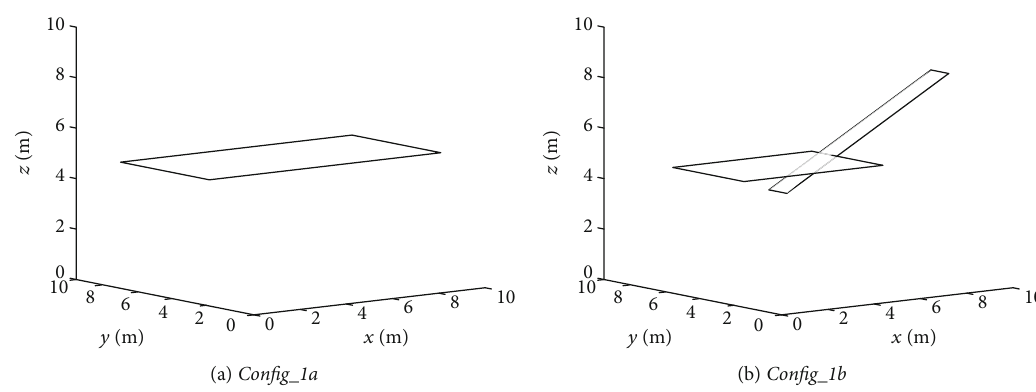
Figure 3: Simple fracture con fi gurations